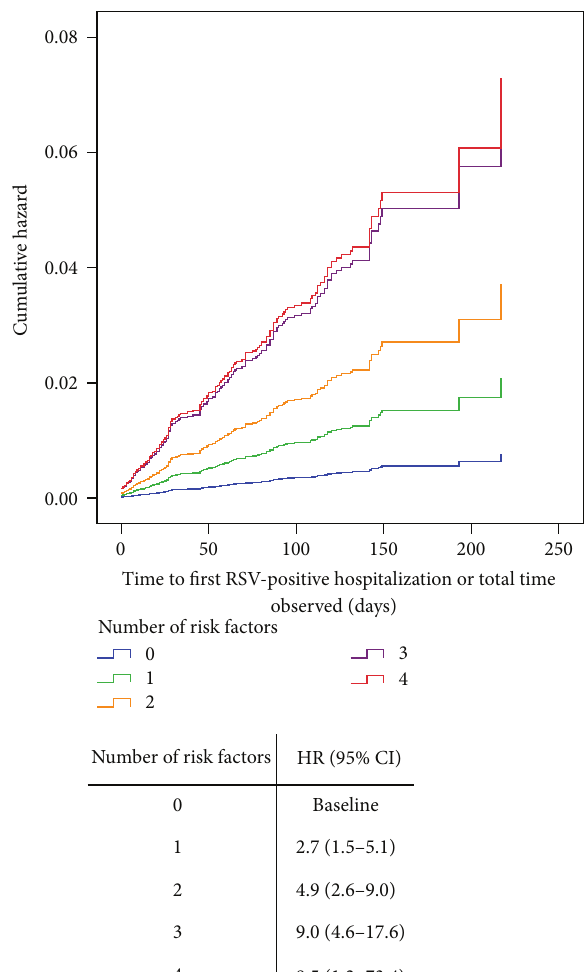
Figure 5: Hazard curves for the Cox proportional regression based on the number of risk factors per infant. Risk factors included were siblings, smokers in the household, ≥ 5 individuals in the household, and attending